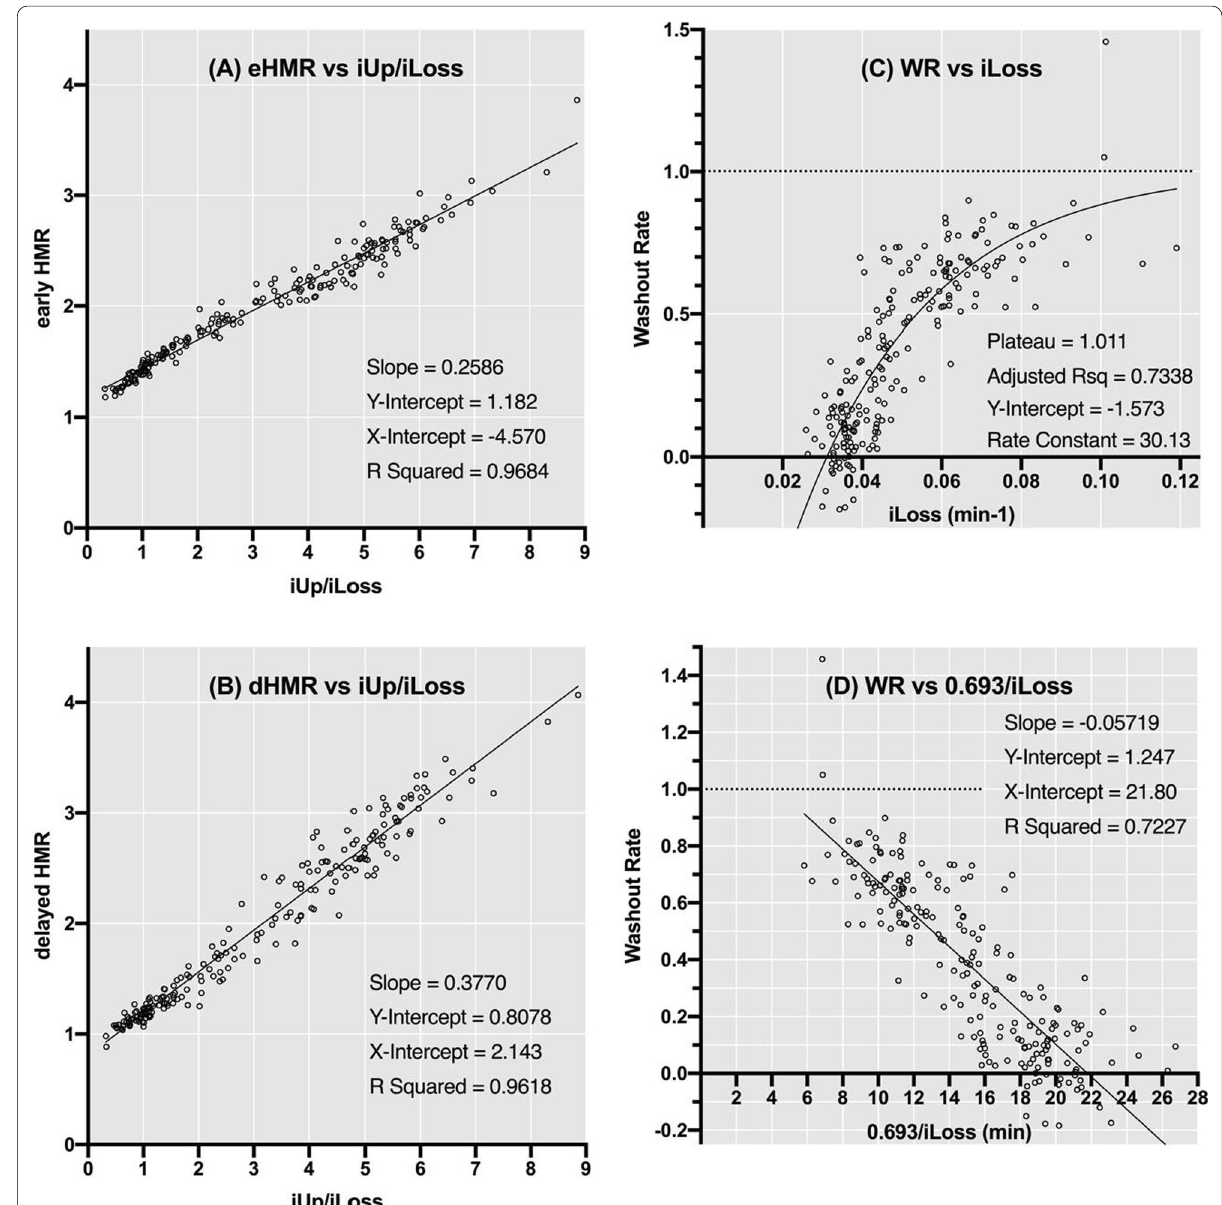
Fig. 2 The results of regressions between the existing indices and new indices of 123 I‑MIBG myocardial scintigraphy. Linear regressions between iUp/iLoss and the early (eHMR) ( A ) and delayed HMR (dHMR) ( B ) are shown. A nonlinear regression with an exponential monomolecular growth model between iLoss and WR ( C ) can be converted to a linear regression between 0.693/iLoss and WR ( D